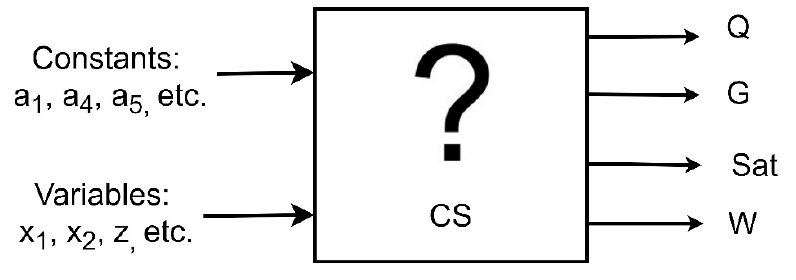
Figure 2. Black box model.